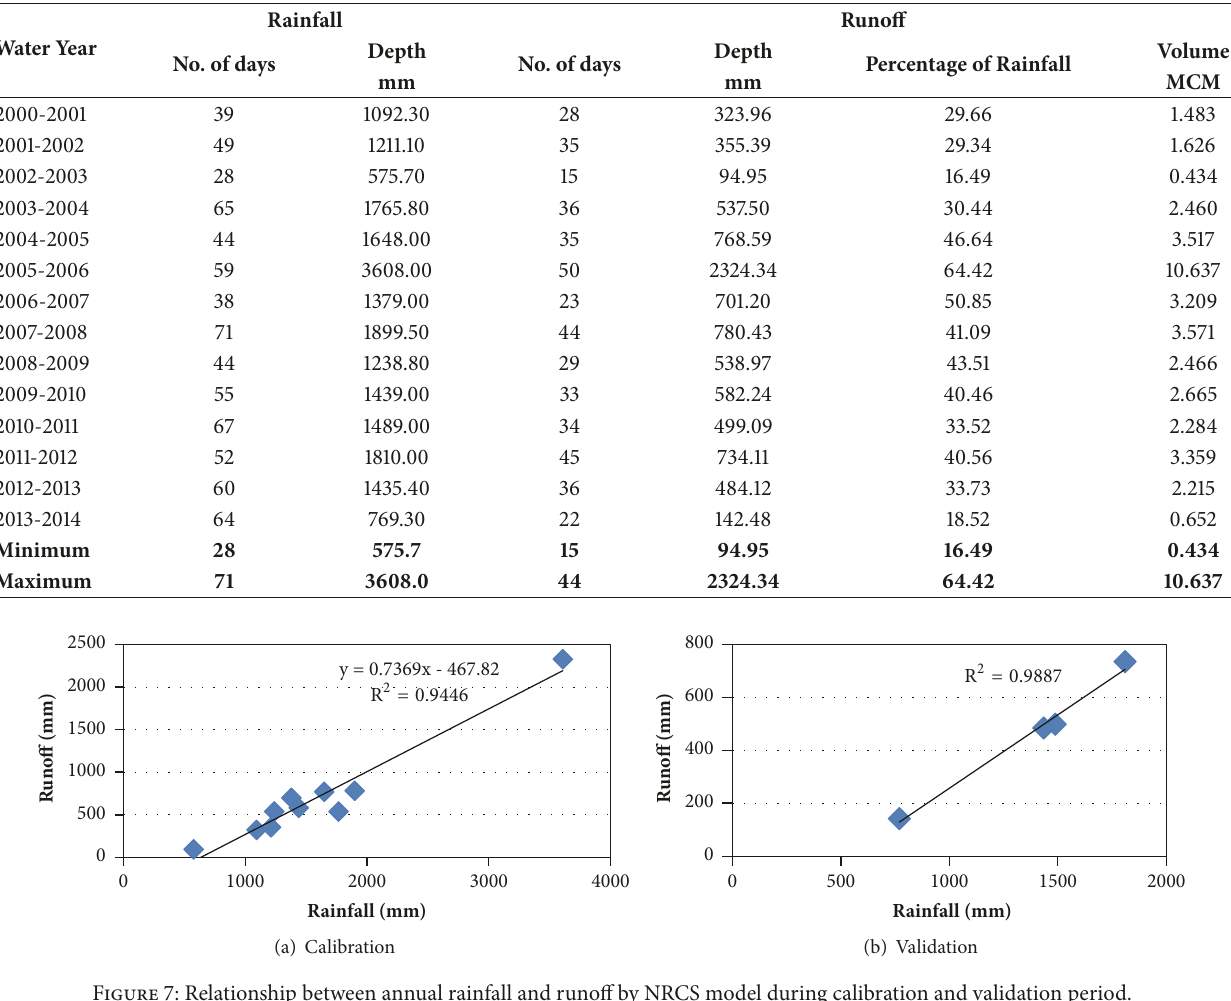
Table 4: Annual rainfall and runoff estimated for Urapakkam watershed using NRCS model for the period 2000-01 to 2013–14. Wate r Yea r